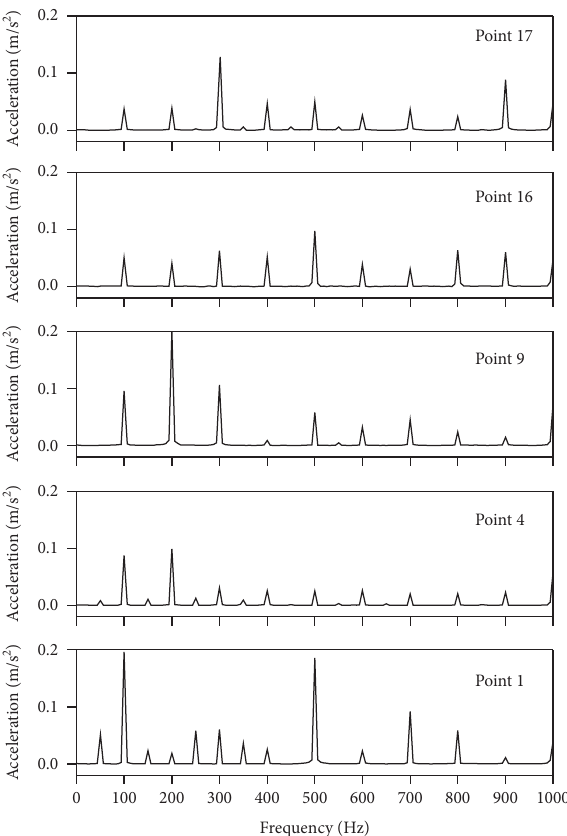
Figure 19: Peak vibration spectrum characteristics of the iron core.